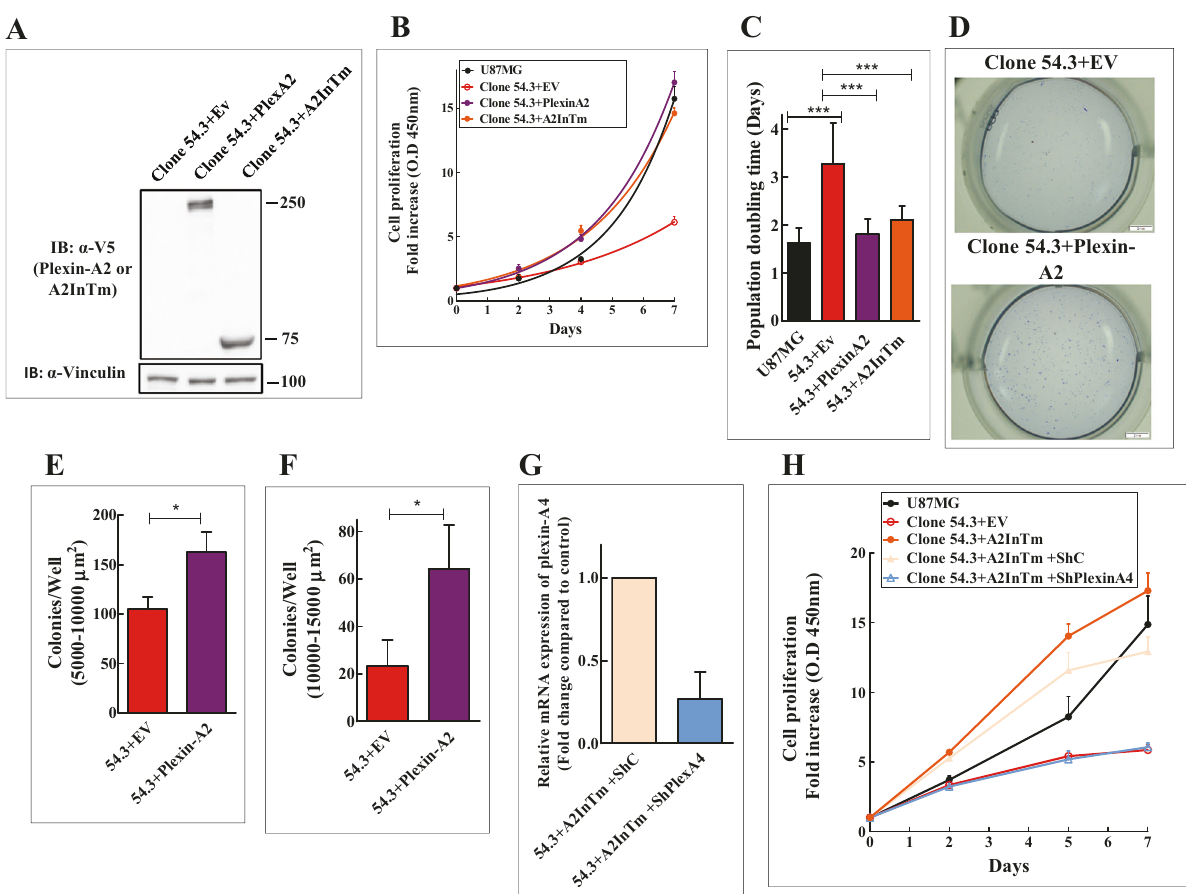
Fig. 4 Re-expression of a truncated plexin-A2 containing the intracellular and trans-membrane domains (A2InTm) of plexin-A2 restores cell proliferation of plexin-A2 knock-out cells. A Plexin-A2 knock-out clone 54.3 cells were infected with an empty lentiviral expression vector (EV) or a lentiviral vector directing expression of a V5 tagged full length plexin-A2 (PlexA2) or a truncated plexin-A2 containing the intracellular and trans-membrane domains of plexin-A2 (A2InTm). Western blots prepared from cell lysates were probed with antibodies directed against V5 and vinculin. B Representative growth curves of U87MG cells and of U87MG KO clone 54.3 cells infected with lentiviruses encoding plexin-A2 (PlexinA2), A2InTm or an empty expression vector (EV). Cells were seeded in quadruplicate in 24 well dishes (1 × 10 4 cells/well). Cells were counted every two days using a coulter-counter. Data are represented as mean ± SD. C The average population doubling time of U87MG cells ( N = 11) was compared with the average population doubling time of clone 54.3 + EV ( N = 11), clone 54.3 + PlexinA2 ( N = 7) and clone 54.3 + A2InTm ( N = 8). Data are represented as mean ± SD. Statistical analysis was done using the one tailed Mann-Whitney test. *** P < 0.001 D Clone 54.3 cells infected with an empty lentiviral expression vector (EV) or with a lentiviral vector directing expression of plexin-A2 were seeded in soft agar in 24 well dishes (1 × 10 3 cells/well) in triplicates. Colonies were stained with crystal violet after 13 days. Shown are photographs of representative wells. E , F The average number of colonies per well with an area between 5000 and 10,000 µm 2 or 10,000 and 15,000 µm 2 were determined. Data are represented as mean ± SD. Statistical analysis was done using the one-tailed Mann-Whitney test. * P < 0.05, N = 3. G Lentiviruses were used to express control (ShC) or a plexin-A4 targeting shRNA (ShPlexA4) in KO clone 54.3 cells expressing A2InTm. The expression of plexin-A4 was then examined using qRT-PCR. Data are represented as mean ± SD, N = 2. H Representative growth curve of U87MG cells and of clone 54.3 cells expressing an empty expression vector (EV) or expressing A2InTm and clone 54.3 cells expressing A2InTm as well as a non-speci fi c shRNA (ShC) or Clone 54.3 cells expressing A2InTm and an shRNA targeting plexin-A4 (ShPlexinA4). The various cells were seeded in quadruplicate in 96 well dishes (3 × 10 3 cells/well). The proliferation of the cells was determined every two days using